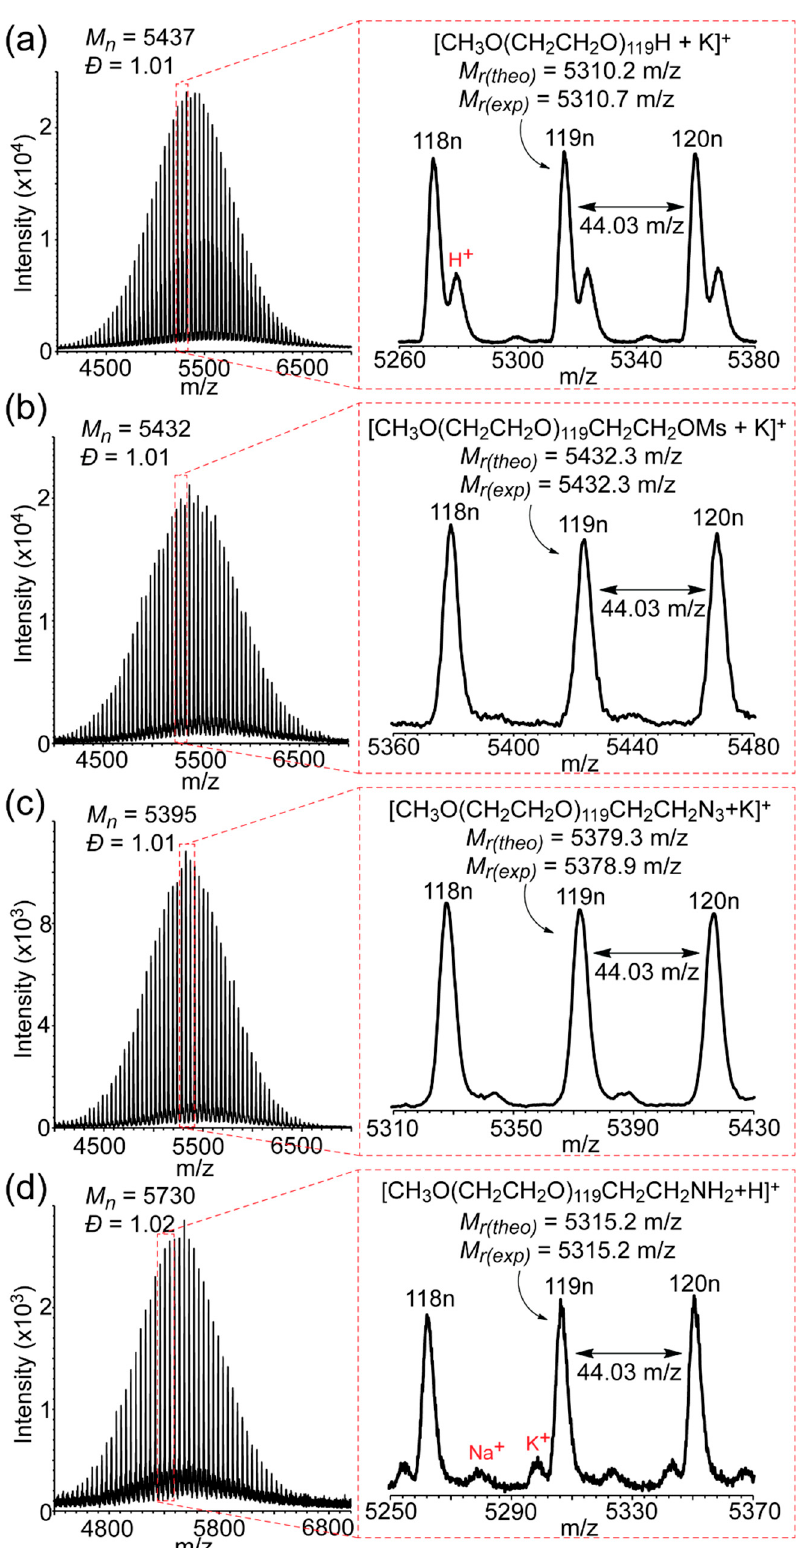
Figure 2. MALDI-ToF MS spectra showing the conversion of the ( a ) α -methoxy- ω -hydroxy PEG 5k to its ( b ) α -methoxy- ω -methylsulfonate, ( c ) α -methoxy- ω -azido and ( d ) α -methoxy- ω -amino derivatives; expansions show the 118–120 repeat unit region of the spectra along with the theoretical ( M r (theo) ) and experimentally ( M r (exp) ) determined average molecular mass values of polymers with n = 119.